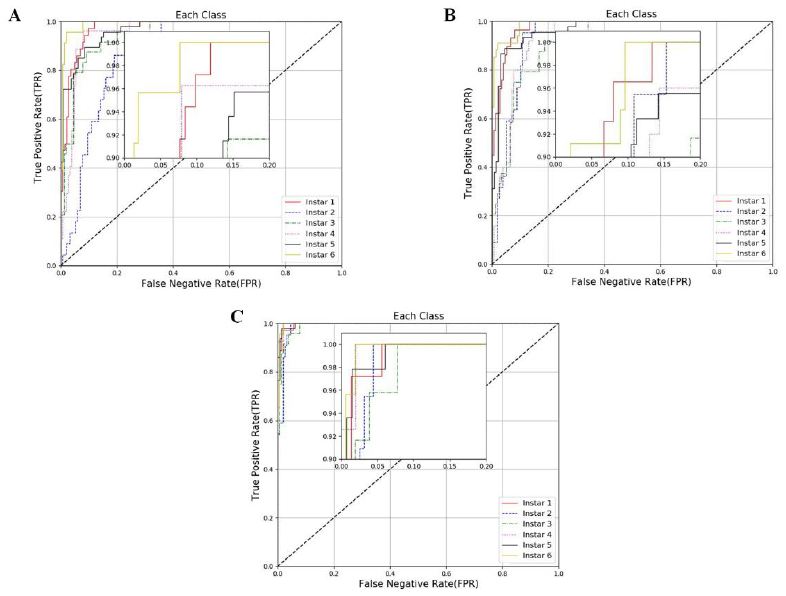
Figure 13. The ROC curves of SVM ( A ), random forest ( B ) and improved random forest ( C ) models. In addition, after hyperparameter tuning and feature dimensionality reduction, the size and recognition speed of the models also change accordingly. The size of the im- proved random forest model is optimized to 1.16 MB, and the recognition speed reaches 36.14 ms/per image. Compared with the original random forest model, the size is reduced by 32.56% and the speed is increased by 63.45%. This is clearly presented in Figure 14. Figure 14. Size comparison of different machine learning models ( A ), ( B ) Comparison of the identification speed of different models for each image. 4. Discussion In this study, we design a low-cost image capturing device and propose an automatic larval instar identification method. The semantic segmentation network combined with improved graphics algorithm is used to realize the automatic detailed calculation of the larval head capsule width and body length, and achieving an MIoU of 93.82% and con- trolled the calculation error within 5%. Meanwhile, the Boruta dimension reduction and double search (RandomizedSearchCV [46] and GridSerachCV [23] algorithm) are used to prevent the overfitting phenomenon and high calculation costs during model training.